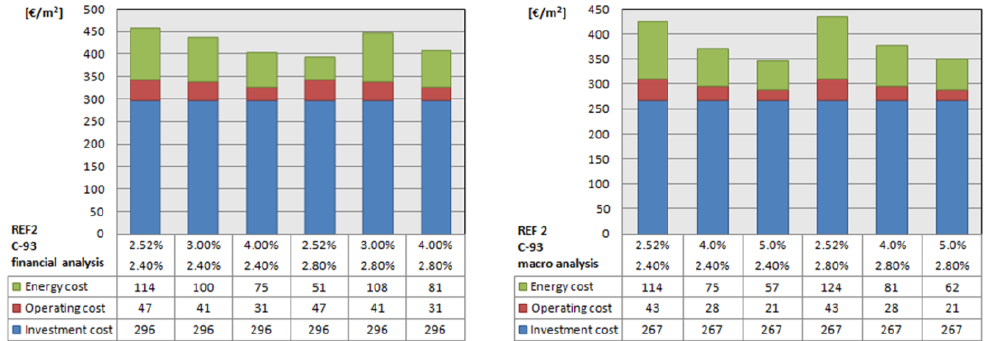
Figure 7. Financial and macroeconomic sensitivity analysis of the best combination for REF2.